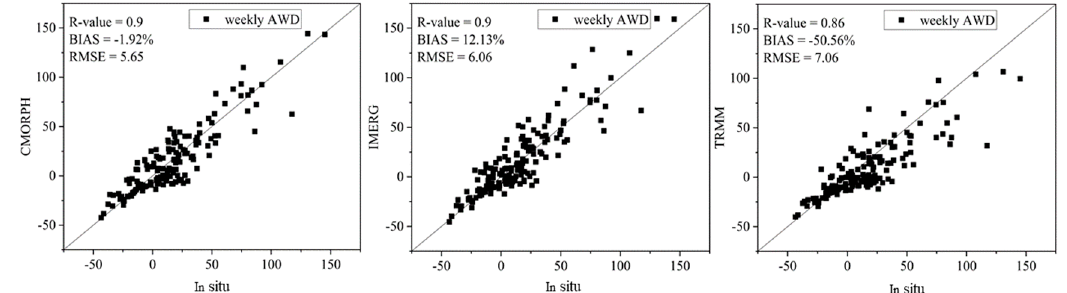
Figure 10. Comparison of the one-week AWD calculated from the satellite-based precipitation products and in situ observations. Table 3. One-week AWD comparison between satellites and in situ observations at each meteorological station.